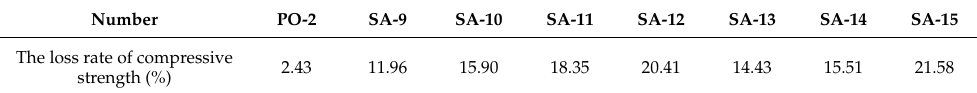
Figure 6. Compressive strength of cement mortar before and after carbonation. Table 6. Loss rate of compressive strength of cement mortar after Table 6. Loss rate of compressive strength of cement mortar after carbonation.